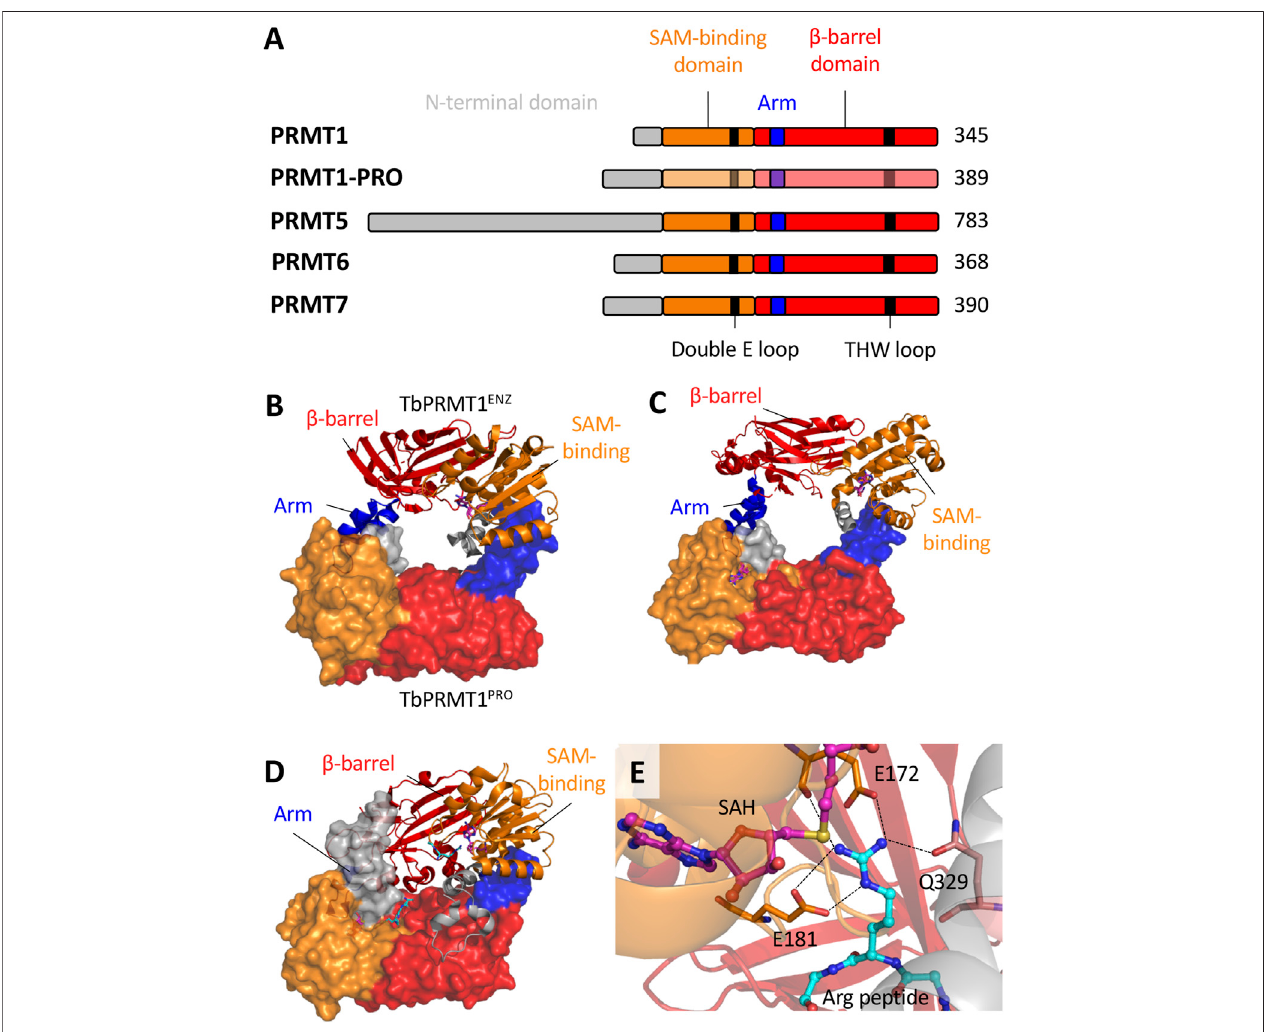
FIGURE 2 | The structural biology of T. brucei PRMTs. (A) , Each of the fi ve PRMT homologs in T. brucei contain the four canonical domains indicated. The SAM- binding domain contains the residues that interact with a SAM molecule and the target arginine substrate. The β -barrel domain contains residues that interact with the argininesubstrate.Thearm(dimerizationarm)withinthe β -barreldomaininteractswithanothersubunitviacontactstotheSAM-bindingdomain. Tb PRMTN-terminihave signi fi cant variability with elusive functional roles. Key conserved double E loop and THW loop are also indicated. B-D, The core dimeric interfaces of (B) Tb PRMT1 ENZ - Tb PRMT1 PRO (PDB: 6DNZ) (C) Tb PRMT6 (PDB: 4LWP) and (D) Tb PRMT7 (PDB: 4M38). The surface structure represents the second subunit (or Tb PRMT1 PRO indicated in B. The SAH and Arg peptides are indicated by pink-blue-red and cyan-blue-red sticks respectively. (E) The active site of Tb PRMT7